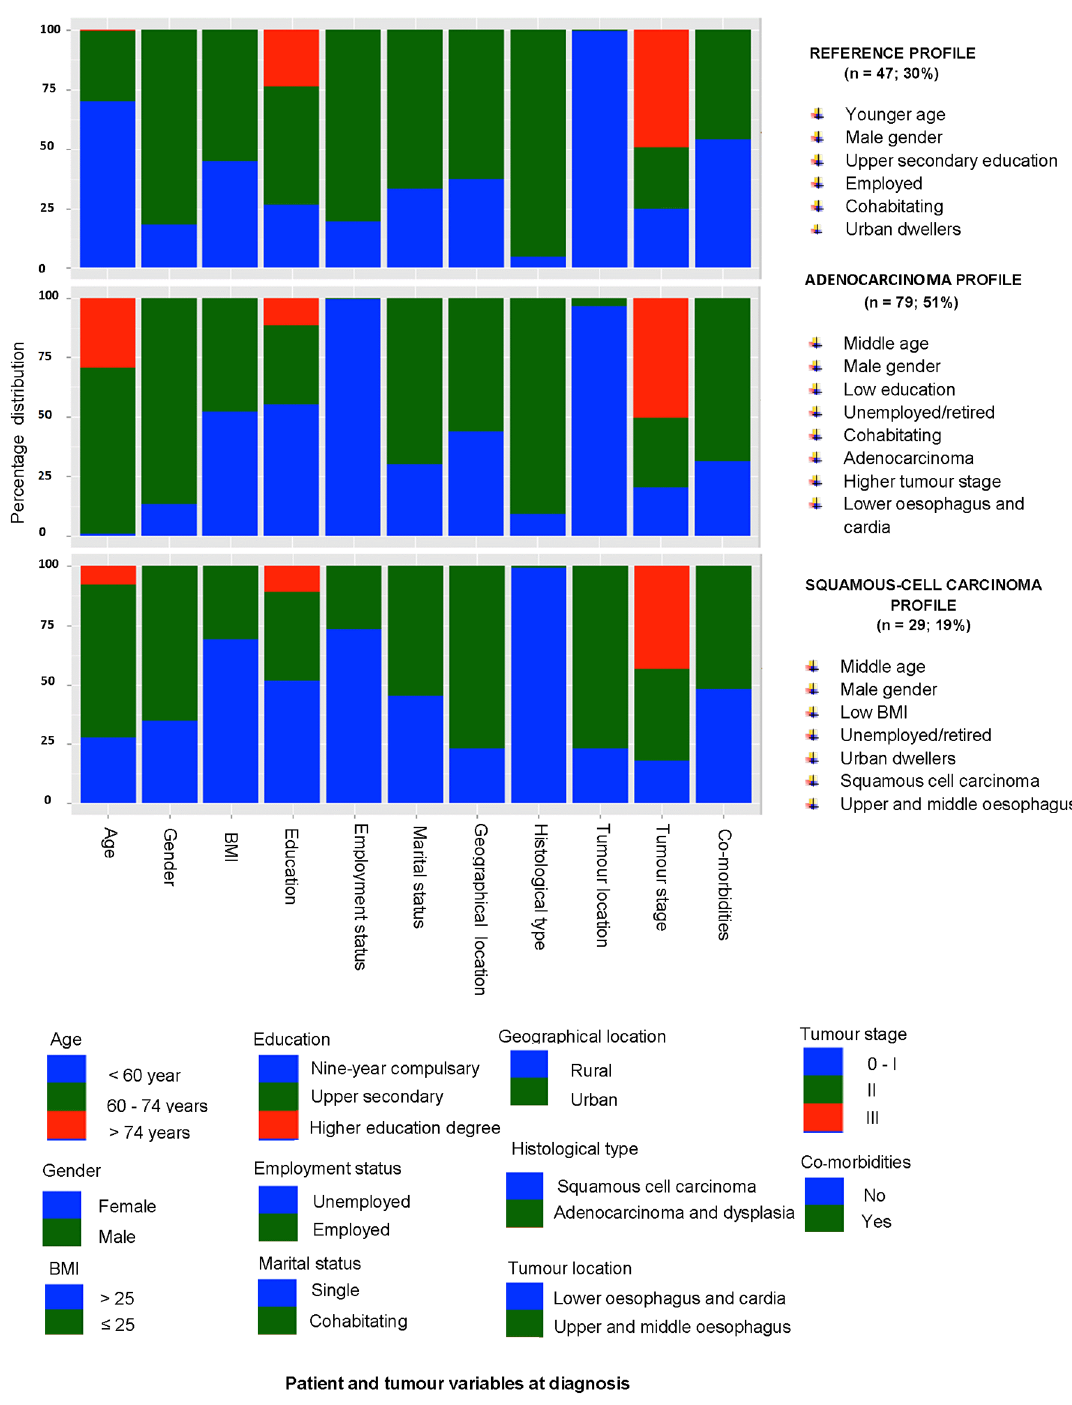
Fig 1. Proportion of socio-demographic, anthropometric and clinical characteristics at diagnosis among the reference, adenocarcinoma and squamous-cell carcinoma profiles created from latent class cluster analysis of 3-year survivors of oesophageal cancer following